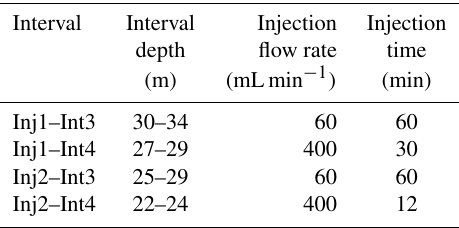
Table 1. Parameters of the packer intervals and the hydraulic to- mography